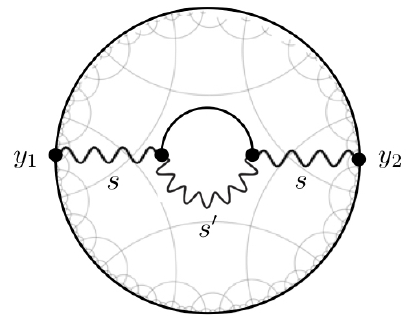
Figure 7. One-loop bubble diagram with a gauge spin- s (cid:12)eld and a scalar propagating internally between two external gauge (cid:12)elds of spin s . Throughout we represent gauge (cid:12)elds with wavy